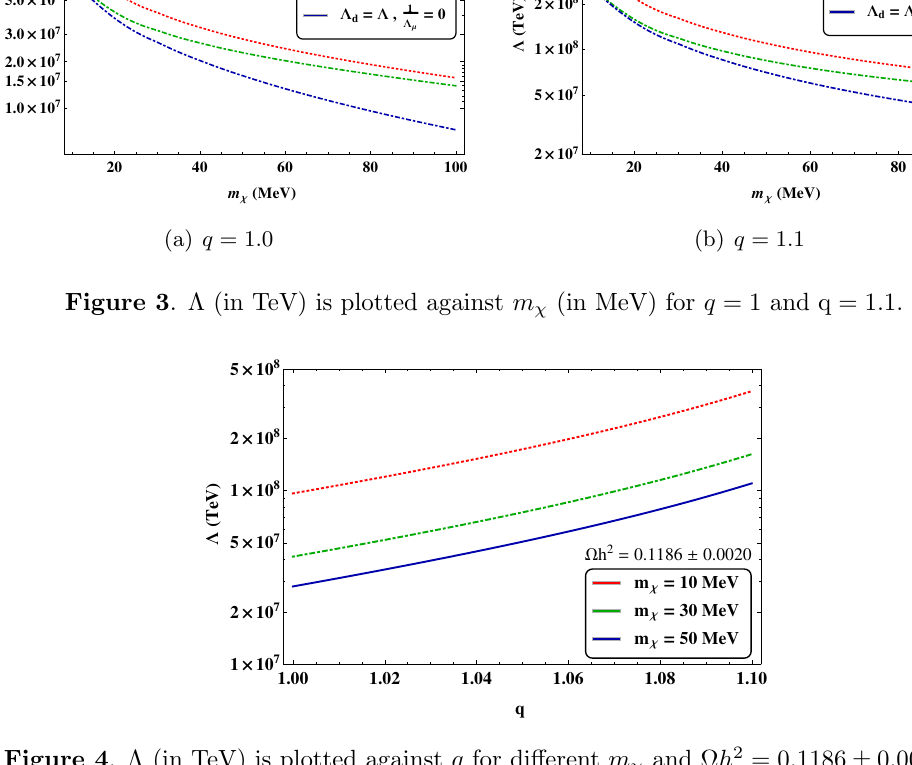
given q , the upper bound on (cid:3) decreases as m increases. As an example, for q = 1 : 0, we (cid:31) see that as m increases from 10 to 100 MeV, (cid:3) (Case III) decreases from 1 (cid:2) 10 8 TeV (cid:31) to 1 : 6 (cid:2) 10 7 TeV. On the right, the same is shown for q = 1 : 1, where (cid:3) changes from (cid:24) 4 (cid:2) 10 8 TeV to (cid:24) 7 (cid:2) 10 7 TeV for the same m range. In (cid:12)gure 4 we have plotted (cid:31)